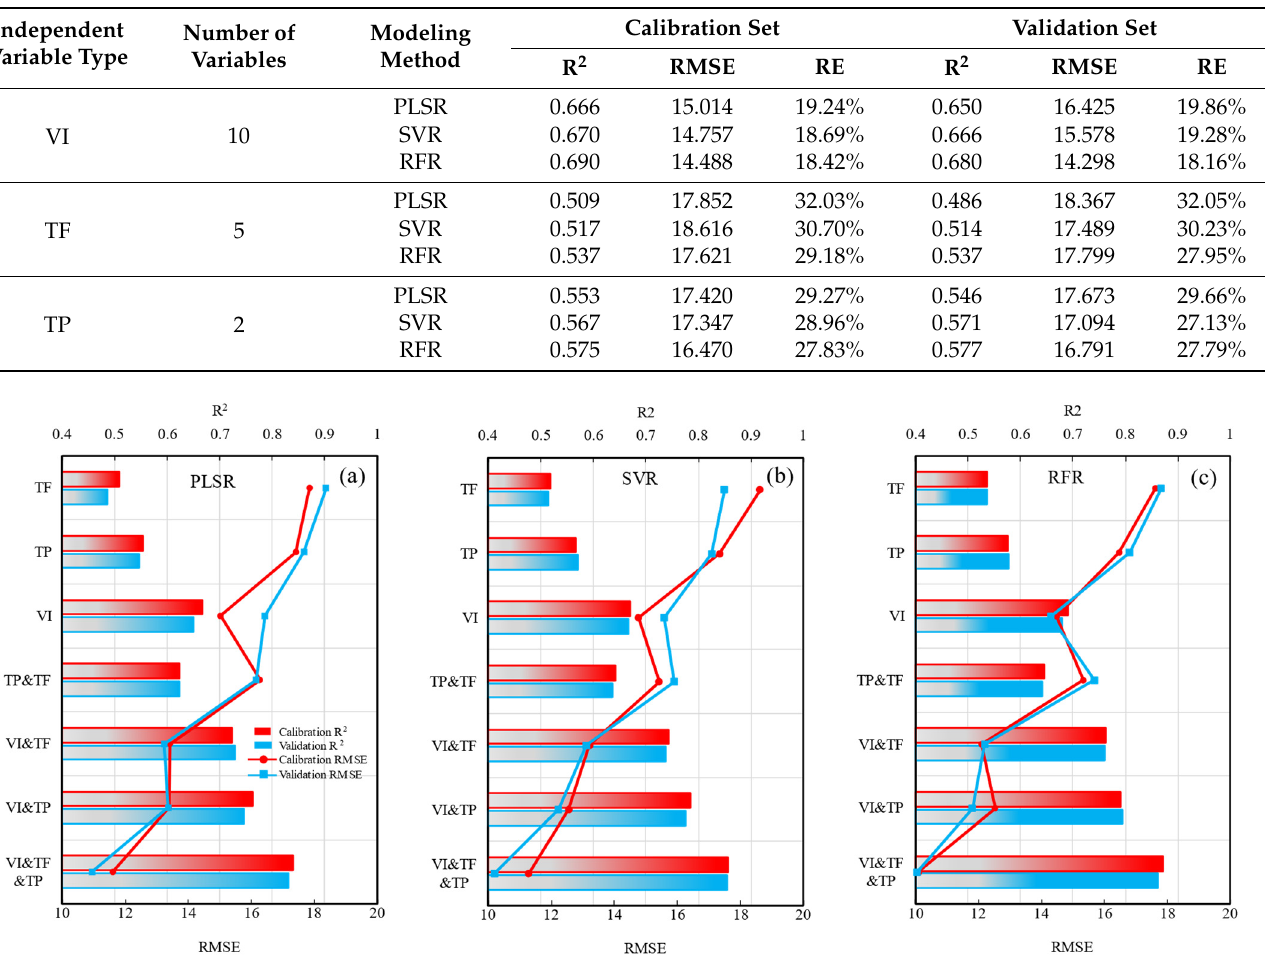
Table 3. Estimation performance of single data source model based on different algorithms.